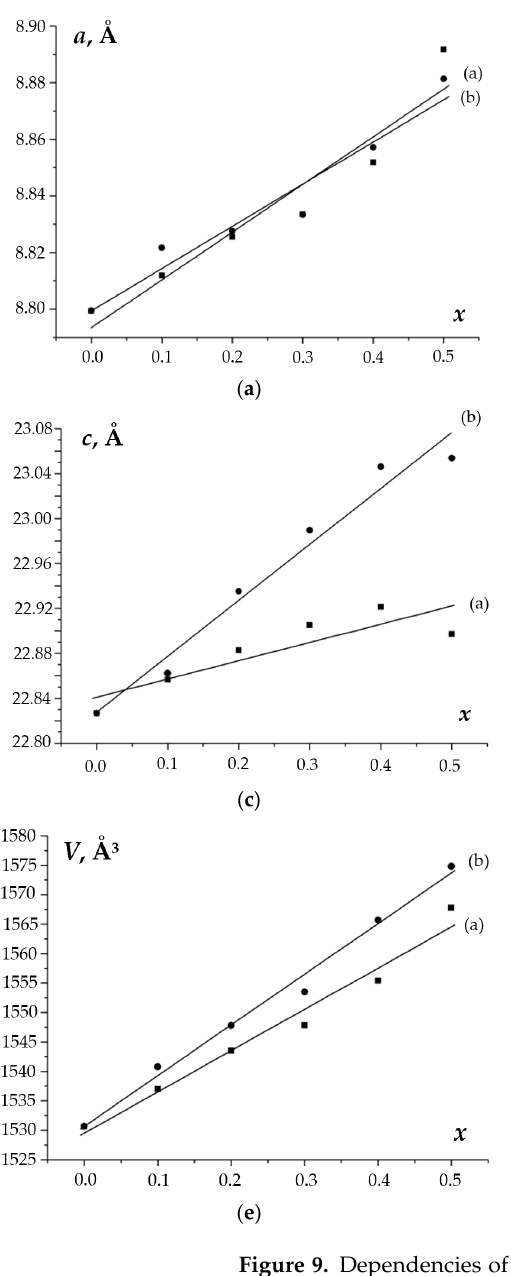
Figure 9. Dependencies of the unit cell parameters a and c , and of the unit cell volume V on the composition ( x ) of phosphates Na 1-x Zr 2 (PO 4 ) 3-x (XO 4 ) x ( a , c , e ) and Ca 0.5(1-x) Zr 2 (PO 4 ) 3-x (XO 4 ) x ( b , d , f ), X = Mo ( a ), W ( b ). The linear fit of the data for the Ca 0.5(1-x) Zr 2 (PO 4 ) 3-x (XO 4 ) x compounds was Ca 0.5(1-x) Zr 2 (PO 4 ) 3-x (XO 4 ) x was R 2 > 0.9 without taking into account x =